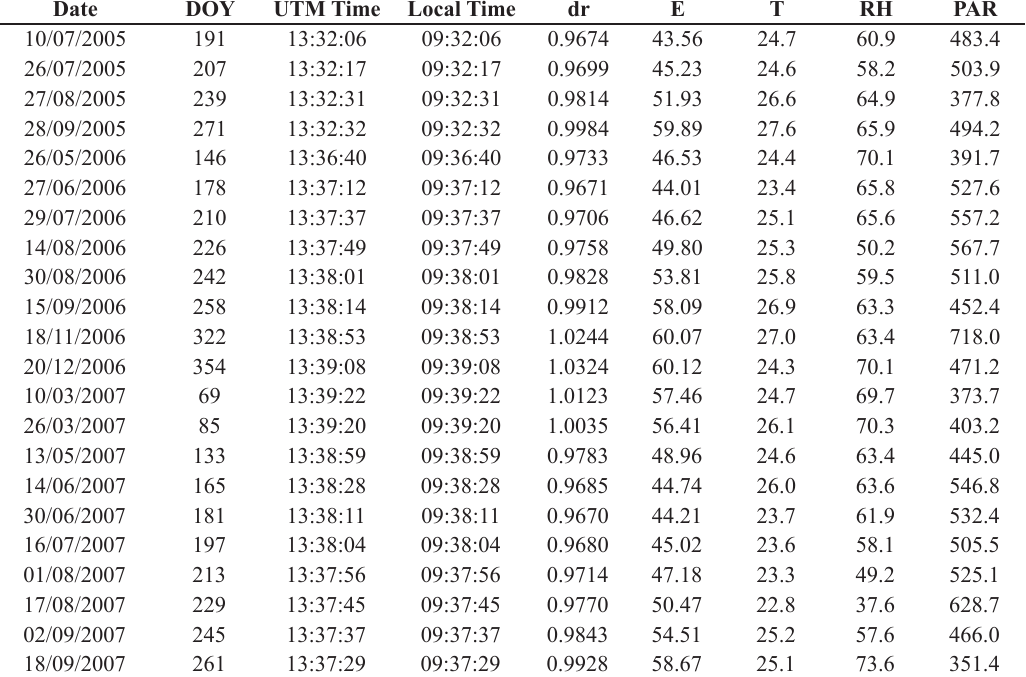
Date, day of the year (DOY), UTM time, local time, square of the earth-sun distance (dr), solar elevation angle (E) of the Landsat 5 TM images and the air temperature (T - ° C) and relatively humidity (RH - %) and photosynthetic active radiation (PAR – W m -2 ) during the Landsat 5 TM overpass in